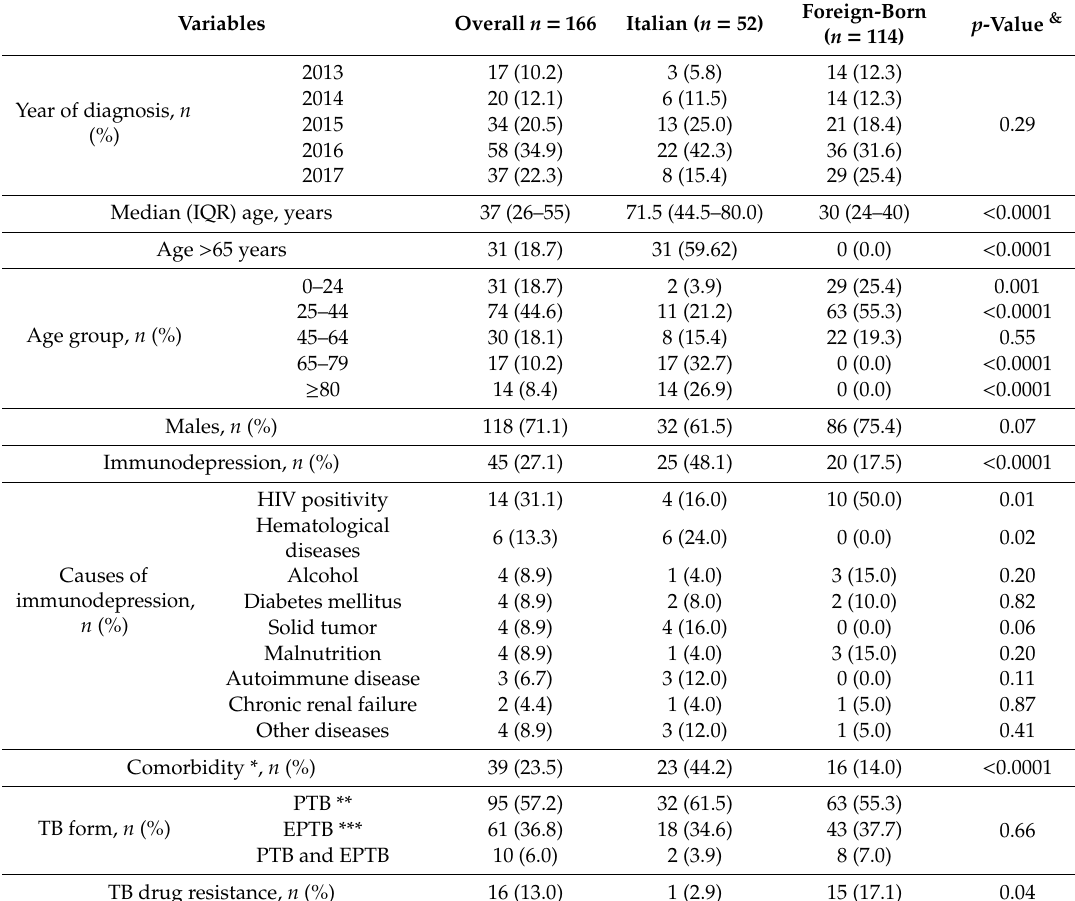
Table 1. Descriptive analysis of patients’ characteristics by their country of